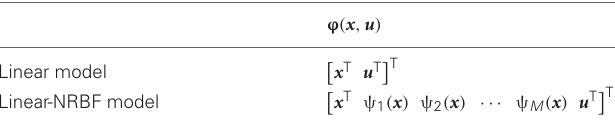
Table 1 | Basis functions used in the swing-up pole simulation.